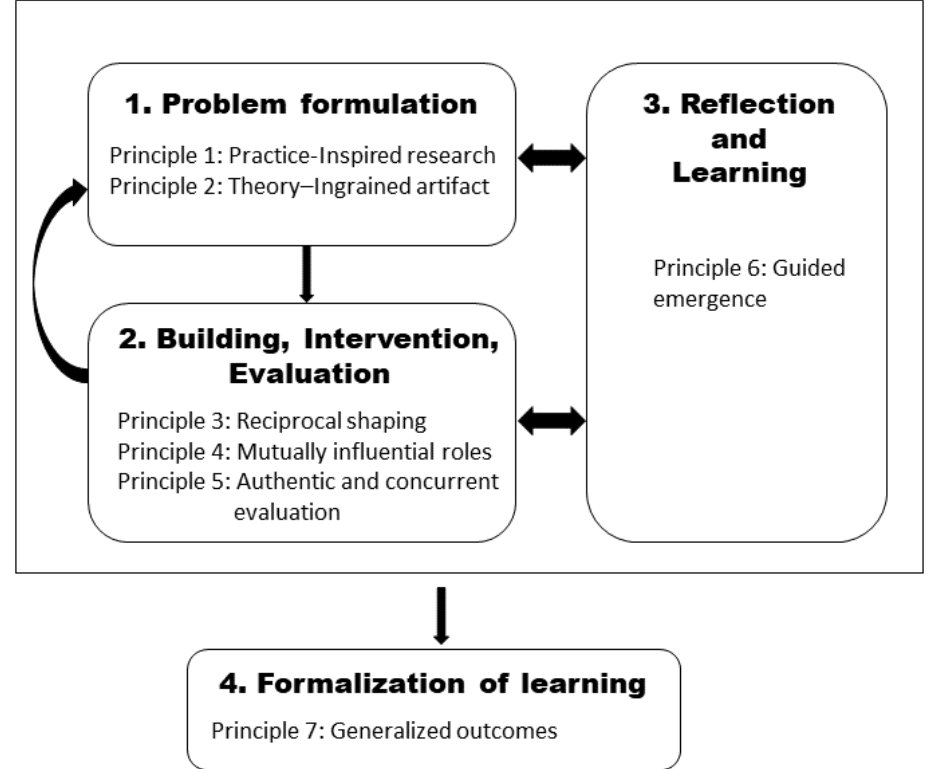
Figure 1. Action design research method: stages and